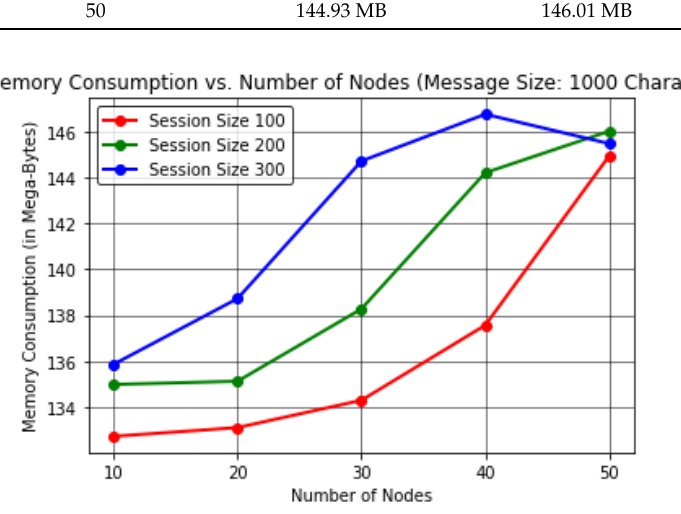
Figure 10. Memory consumption vs. number of